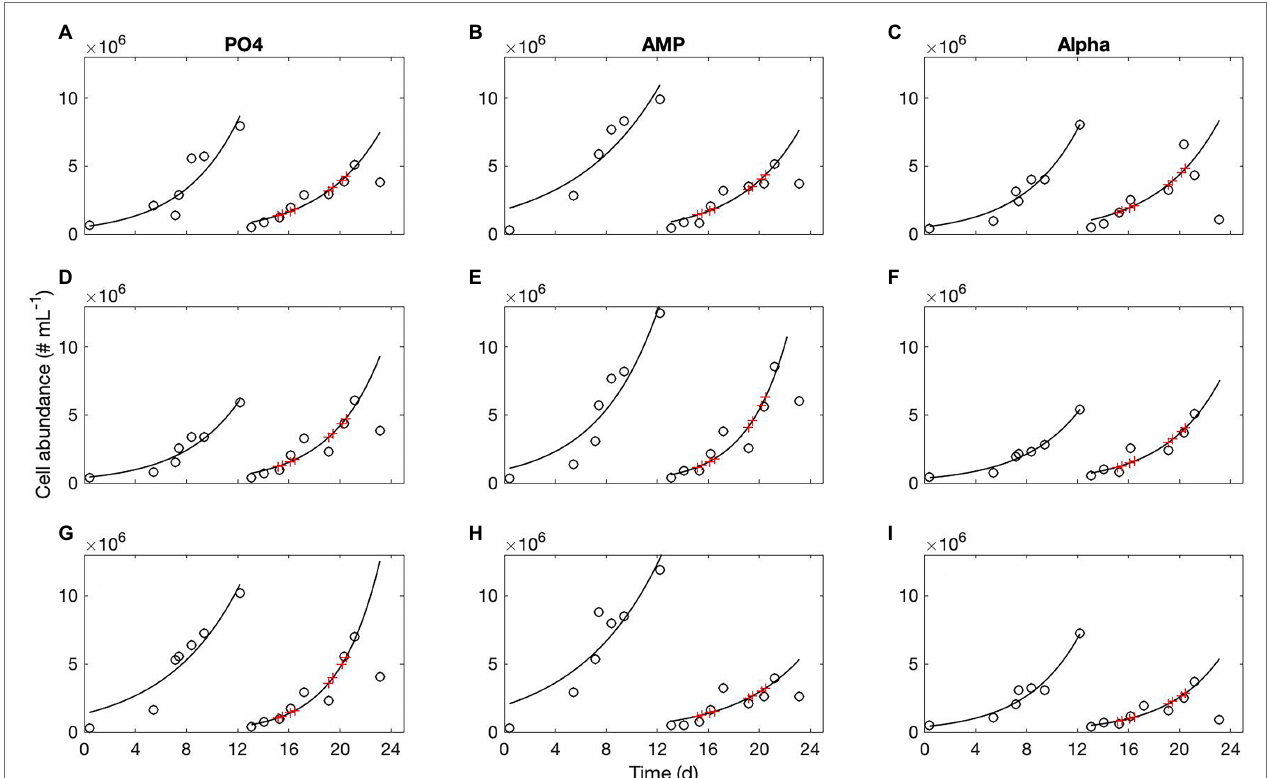
FIGURE 1 | Typical growth curves obtained in three replicates of the PO 4 cultures (A,D,G) , AMP cultures (B,E,H) , and Alpha cultures (C,F,I) . Open symbols, population abundance in cell numbers per ml; red crosses indicate when POP samples were taken for analyses. In this example, all flasks were diluted on day 12 with their respective medium containing either an inorganic (PO 4 ) or organic [mono phosphate adenosin (AMP) or DL- α -glycerophosphate (Alpha)] source of phosphorus for